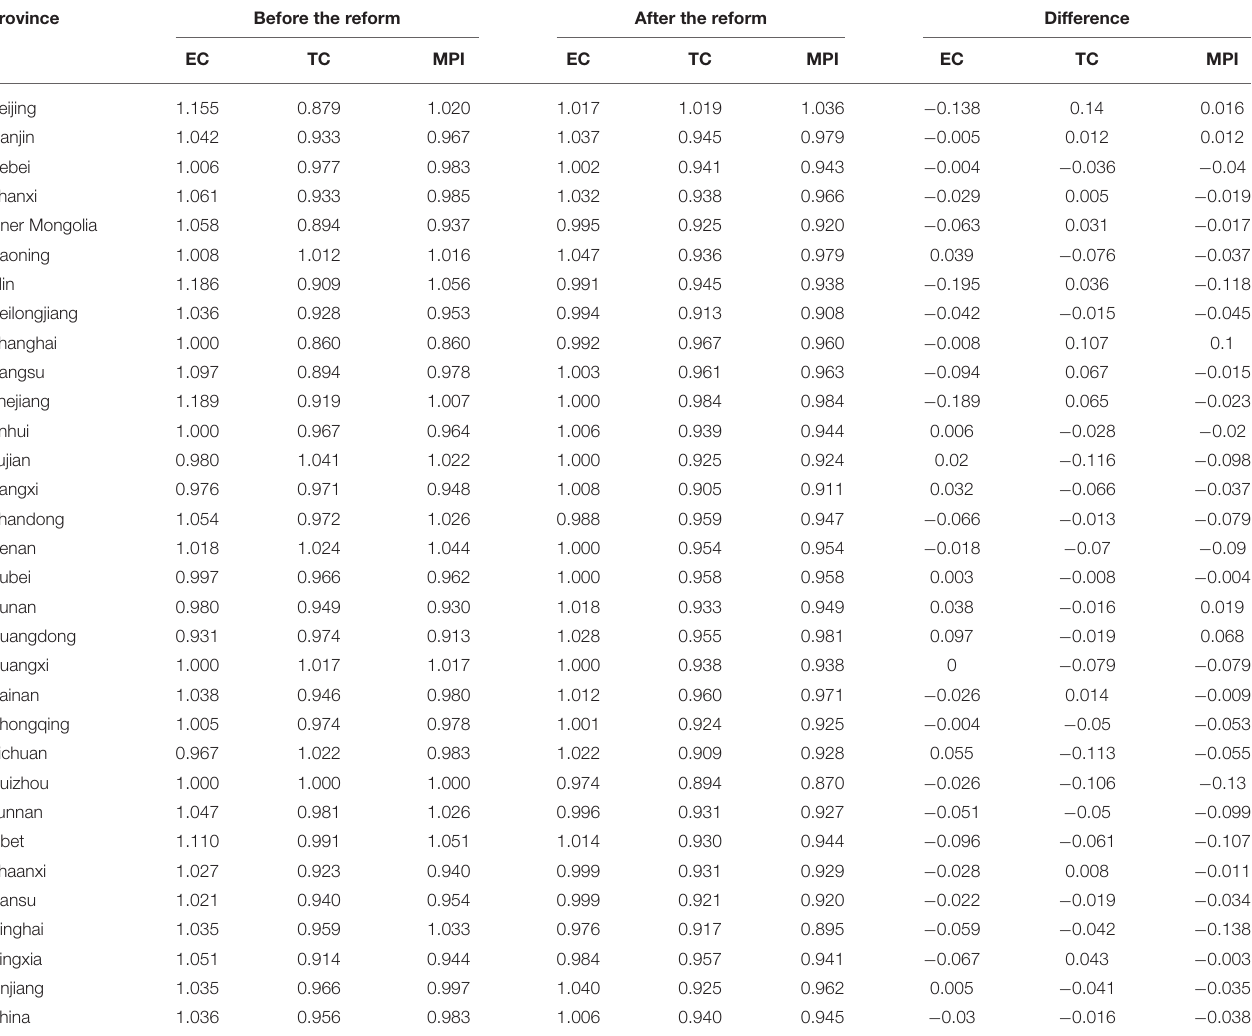
TABLE 3 | Efficiency of PHCIs in provinces before and after the reform in 2009. Province Before the reform After the reform